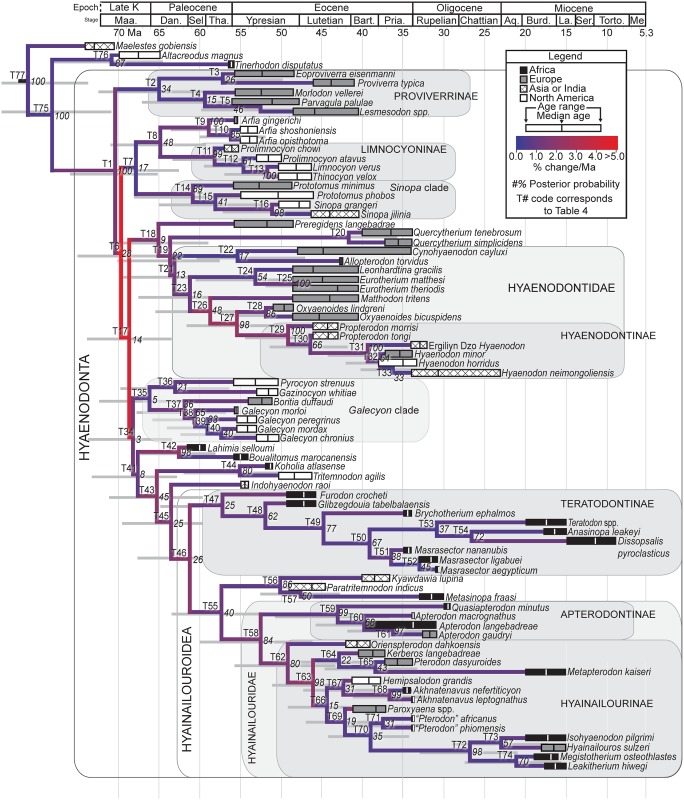
Tip-dating consensus tree.“Allcompat” (majority rule plus compatible groups) consensus derived from the post-burnin sample of trees recovered by tip-dating Bayesian analysis. T# corresponds to S3 Table and the results and discussion section. Posterior probability (PP) shown in italics to the right or below relevant node. Divergence dates represent median divergence date for clades and taxa. The vertical line over each geological age range (see S2 Table for sources of age information) is the median estimated age for the taxon based on the tip-dating analysis. Branch colors correspond to legend for % change/Ma along branches. More rapidly changing branches include more red and more slowly changing branches include more blue. Most rapidly evolving lineages are near the base of Hyaenodonta. Continental area of origin for each taxon is shown by the shading the proposed age range: black, Afro-Arabia; grey, Europe; checked, Asia or India; white, North America. Aq., Aquitanian; Bart., Bartonian; Burd., Burdigalian; Dan., Danian; La., Langhian; Late K, Late Cretaceous; Maa., Maastrichtian; Me., Messinian; Pria., Priabonian; Sel., Selanian; Ser., Serravallian; Tha., Thanetian; Torto., Tortonian.